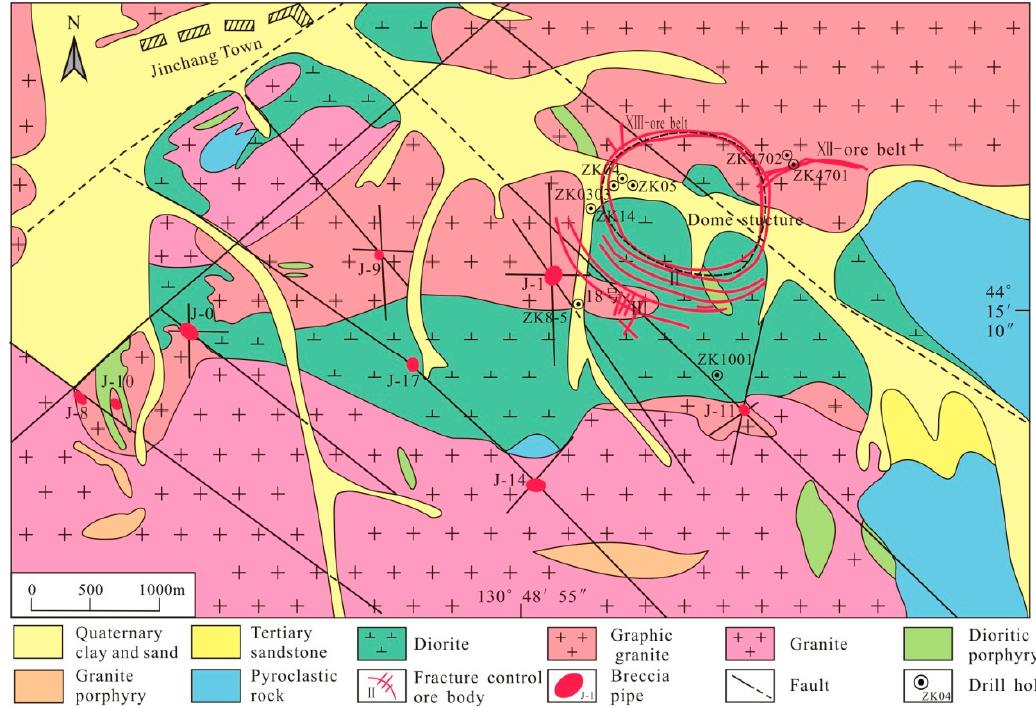
Figure 2. Geological map of the Jinchang gold deposit (modified after Zhang et al. [19]).